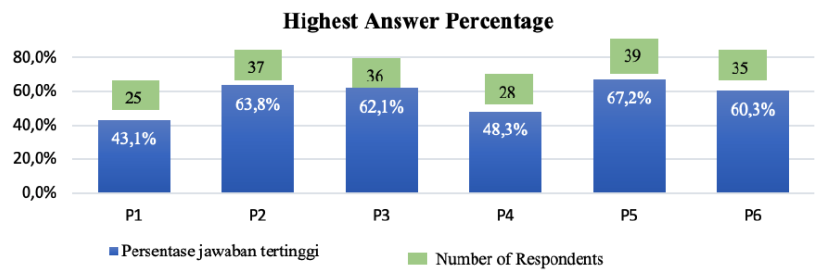
Figure 6: Percentage of Supporters for the Implementation of Career Service Programs by